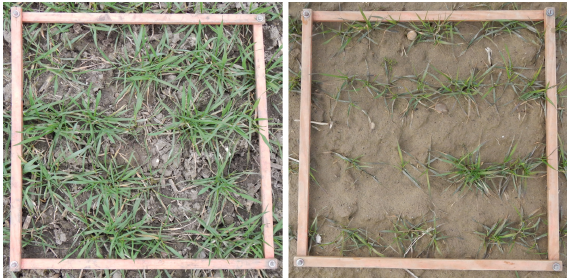
Figure 9. Wheat field “BuBio” at 17th of March 2017 ( left ) and wheat field “G” at 15th of March 2018 ( right